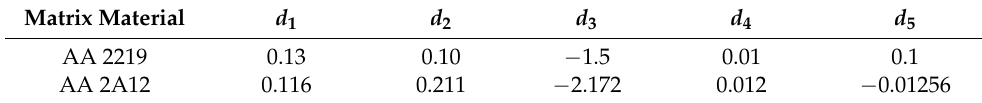
Table 8. Failure parameters for the Jonhson-Cook failure criterion of AA 2219 and AA 2A12. Matrix Material Figure 10. Finite element simulation results of the FE model of the tool–workpiece pair.